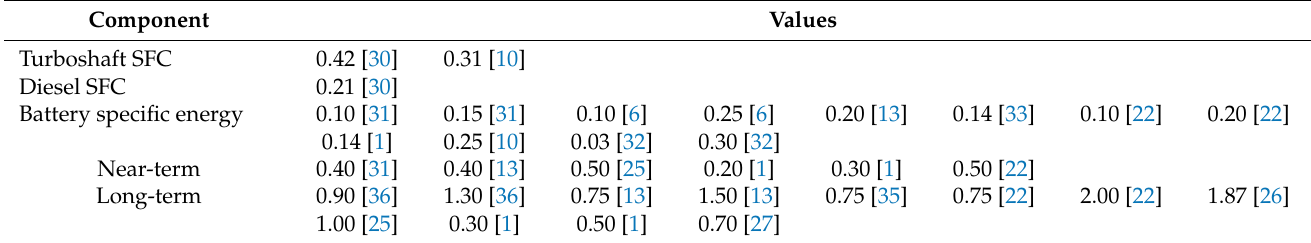
Table 4. Specific energy and specific fuel consumption found from literature.